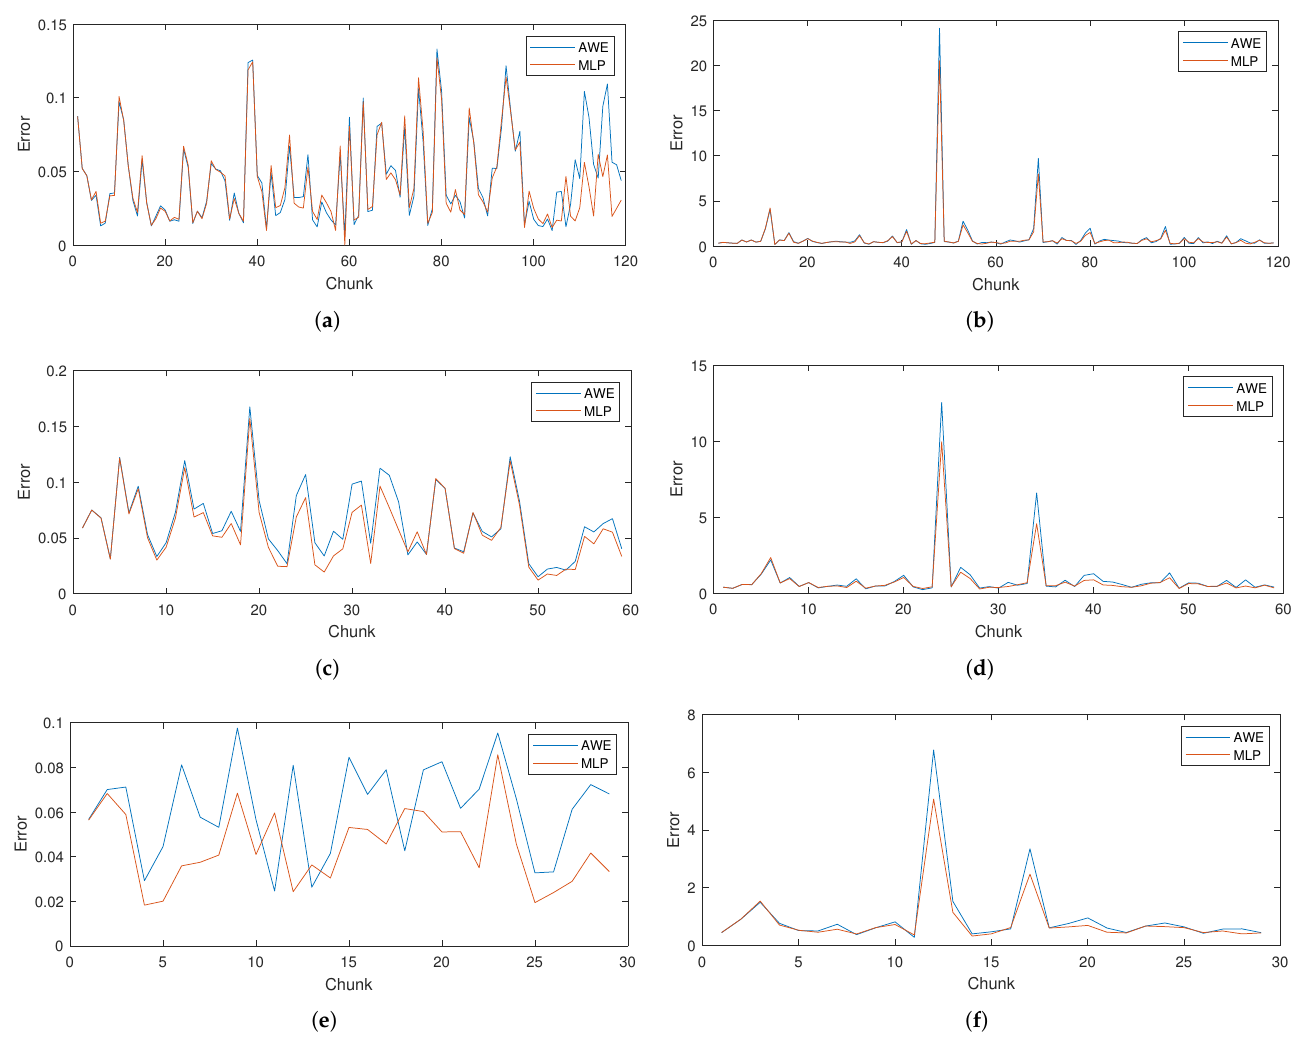
Figure 16. Efficiency of machine learning-based traffic prediction–error for consecutive data chunks. ( a ) SIX dataset, 6-h window, ( b ) WASK dataset, 6-h window, ( c ) SIX dataset, 12-h window, ( d ) WASK dataset, 12-h window, ( e ) SIX dataset, 24-h window, ( f ) WASK dataset, 24-h